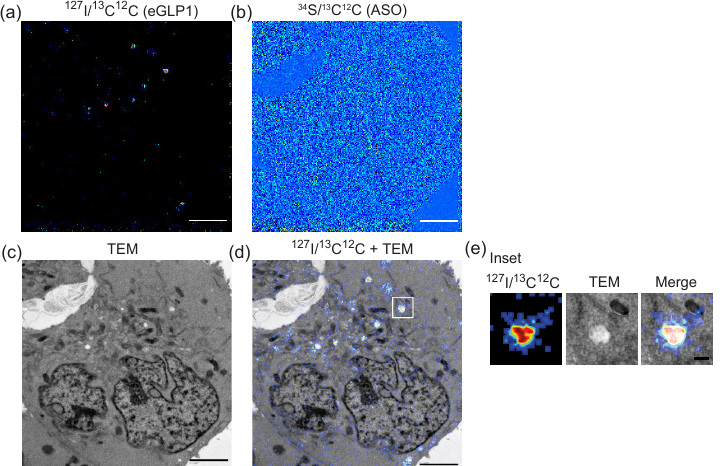
Figure 7. ( a ) 127 I/ 13 C 12 C image of an HEK293 cell treated with 1 μ M 127 I 2 -eGLP1- 34 S 15 -ASO for 30 min. ( b ) 34 S/ 13 C 12 C (ASO) image of the same cell. ( c ) TEM micrograph of the same cell. ( d ) TEM/ 127 I/ 13 C 12 C image overlay. ( e ) Zoom of inset in ( d ) to show a single endosome containing 127 I 2 -eGLP1. Scale bar = 3 μ m. Scale bar inset = 300 nm.